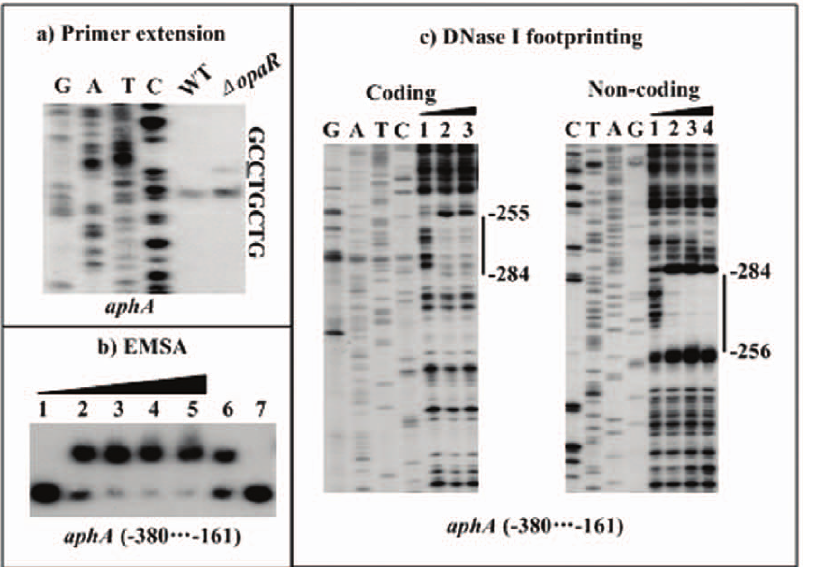
Figure 7. Repression of aphA by OpaR. For primer extension (a), an oligonucleotide primer was designed to be complementary to the RNA transcript of aphA . For EMSA (b) and DNase I footprinting (c), the DNA fragment from the 380th to 161th bp upstream of aphA was incubated with increasing amounts of purified His-OpaR protein. The experiments were done as described in Fig. 5. The transcription start site of aphA were underlined in the DNA sequence. Lanes G, A, T, and C represented the Sanger sequencing reactions. The footprint regions were indicated with vertical bars.. The minus numbers indicated the nucleotide positions upstream of aphA .